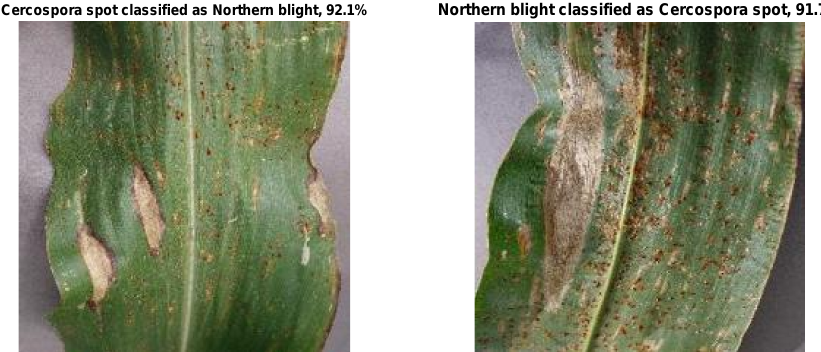
Figure 4. A sample of wrongly classified images along with the class probability. Increasing the size of the training data subset provide results that corroborate and confirm the good performance that was achieved. Tables 3 and 4 show the mean overall F1 score, precision, recall, specificity, and accuracy for all models using 70% and 90% of the data for testing, respectively. The Inceptionv3 could not keep up with the lead. Instead, the DarkNet-53 benefitted better from more training data and achieved an F1 score of 97.5% using 70% of the data for training, and 98.0% using 90% of the data of training. The corresponding accuracy values were 98.2% and 98.6%, respectively. Moreover, with an increase size of the training dataset, it exhibited less fluctuation in the accuracy over different